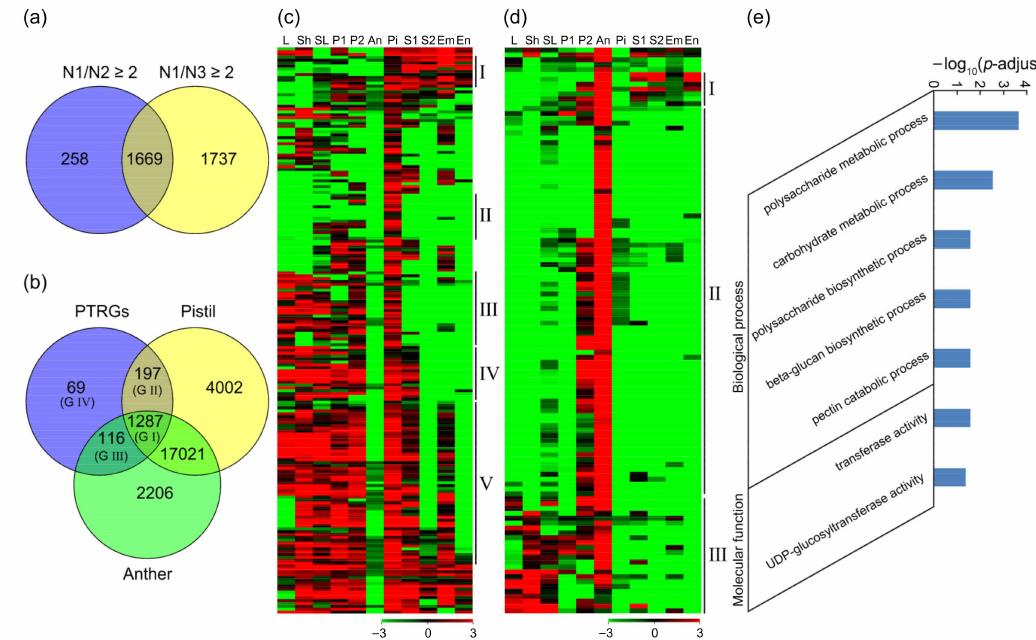
Figure 4. Identification and analysis of the pollen tube-related genes in rice. ( a ) Venn analysis of the 1927 (258 + 1669) genes downregulated in N2 and the 3406 (1669 + 1737) genes downregulated in N3, both compared with N1. ( b ) Venn analysis of the 1669 pollen tube-related genes. Among the 1669 N1-preferential genes, there were 1287 genes (Group I, G I) expressed in both pistil and anther, 197 genes (Group II, G II) expressed in pistil but not in anther, 116 genes (Group III, G III) expressed in anther but not in pistil, and 69 genes (Group IV, G IV) not expressed in pistil and anther. ( c ) Heat map of the 197 pistil-specific genes. ( d ) Heat map of the 116 anther-specific genes. ( e ) GO enrichment analysis of the 116 anther-specific genes. N1, WT pistil at 1–20 min after pollination; N2, WT pistil at 3.5 HAP; N3, WT pistil at 8 HAP; PTRGs, pollen tube-related genes; L, 20-day-old leaf; Sh, 14-day-old seedling on the ground (shoot); SL, seedling at four-leaf stage; P1, panicle before emerging from the sheath of the flag leaf; P2, panicle after emerging from the sheath of the flag leaf; An, mature anther; Pi, mature pistil before pollination; S1, seed at 5 days after pollination (DAP); S2, seed at 10 DAP; Em, embryo at 25 DAP; En, endosperm at 25